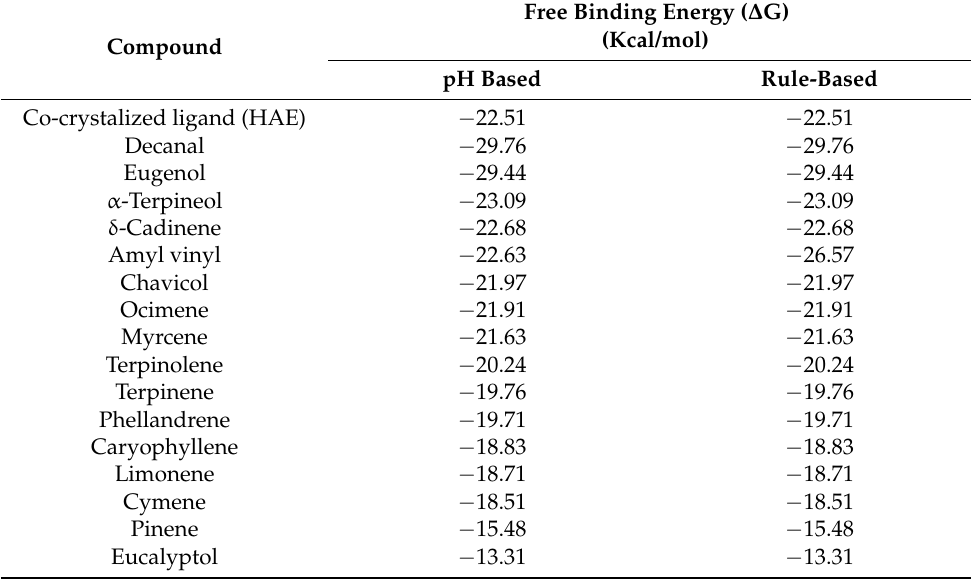
Table 4. Free binding energies ( ∆ G) calculated in kcal/mol of the identified phytoconstituents within H. pylori urease (1E9Y) active site, adopting pH-based and rule-based ionization techniques using Discovery Studio